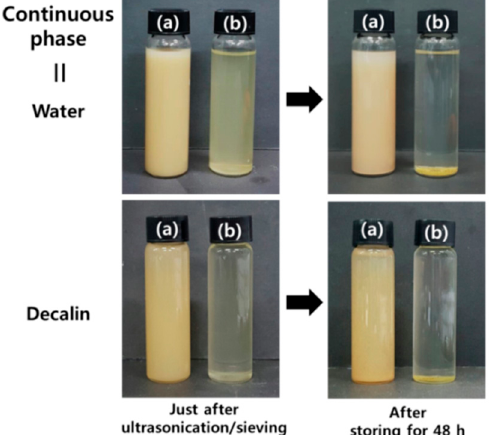
Figure 2. Photographs of dispersions of PMDA-ODA particles in water ( top ) and decalin ( bottom ) synthesized using ( a ) water and ( b ) NMP. The photographs were taken just after ultrasonication/sieving and after storing the samples for 48 h at room temperature.